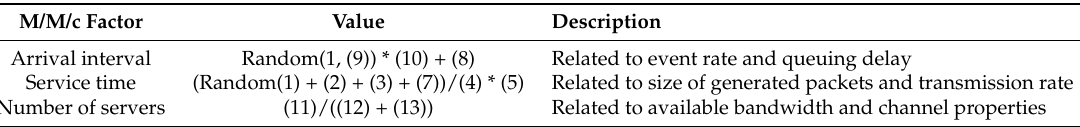
Table 2. M/M/c factors of queuing